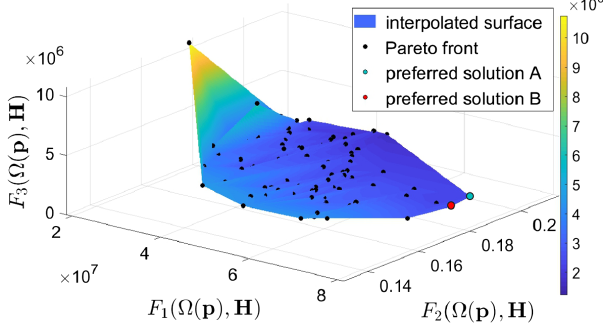
FIG. 8. Convergence to the Pareto front using the VBS-based approach (23) for several initial points N ¼ 101 .